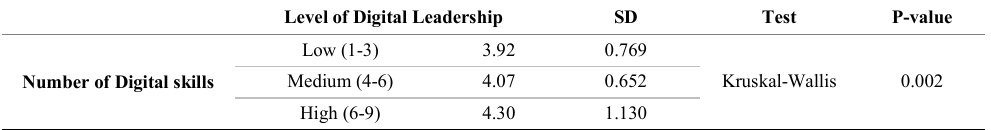
Table 24. Digital Leadership – Number of Digital